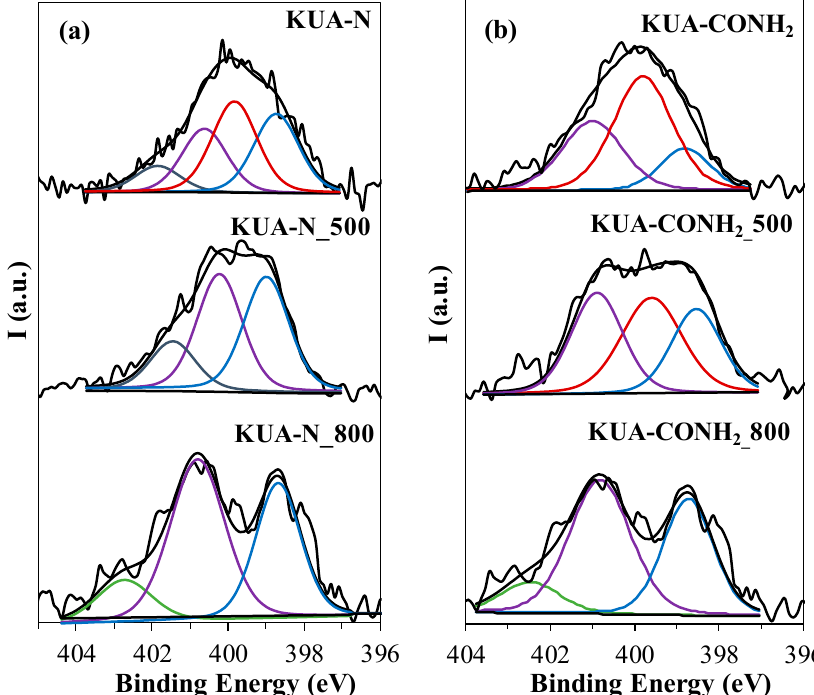
Figure 4. N1s XPS spectra deconvoluted for (a) KUA-N, KUA-N_500 and KUA-N_800 activated carbons and (b) KUA-CONH 2 , KUA-CONH 2 _500 and KUA-CONH 2 _800 activated carbons.